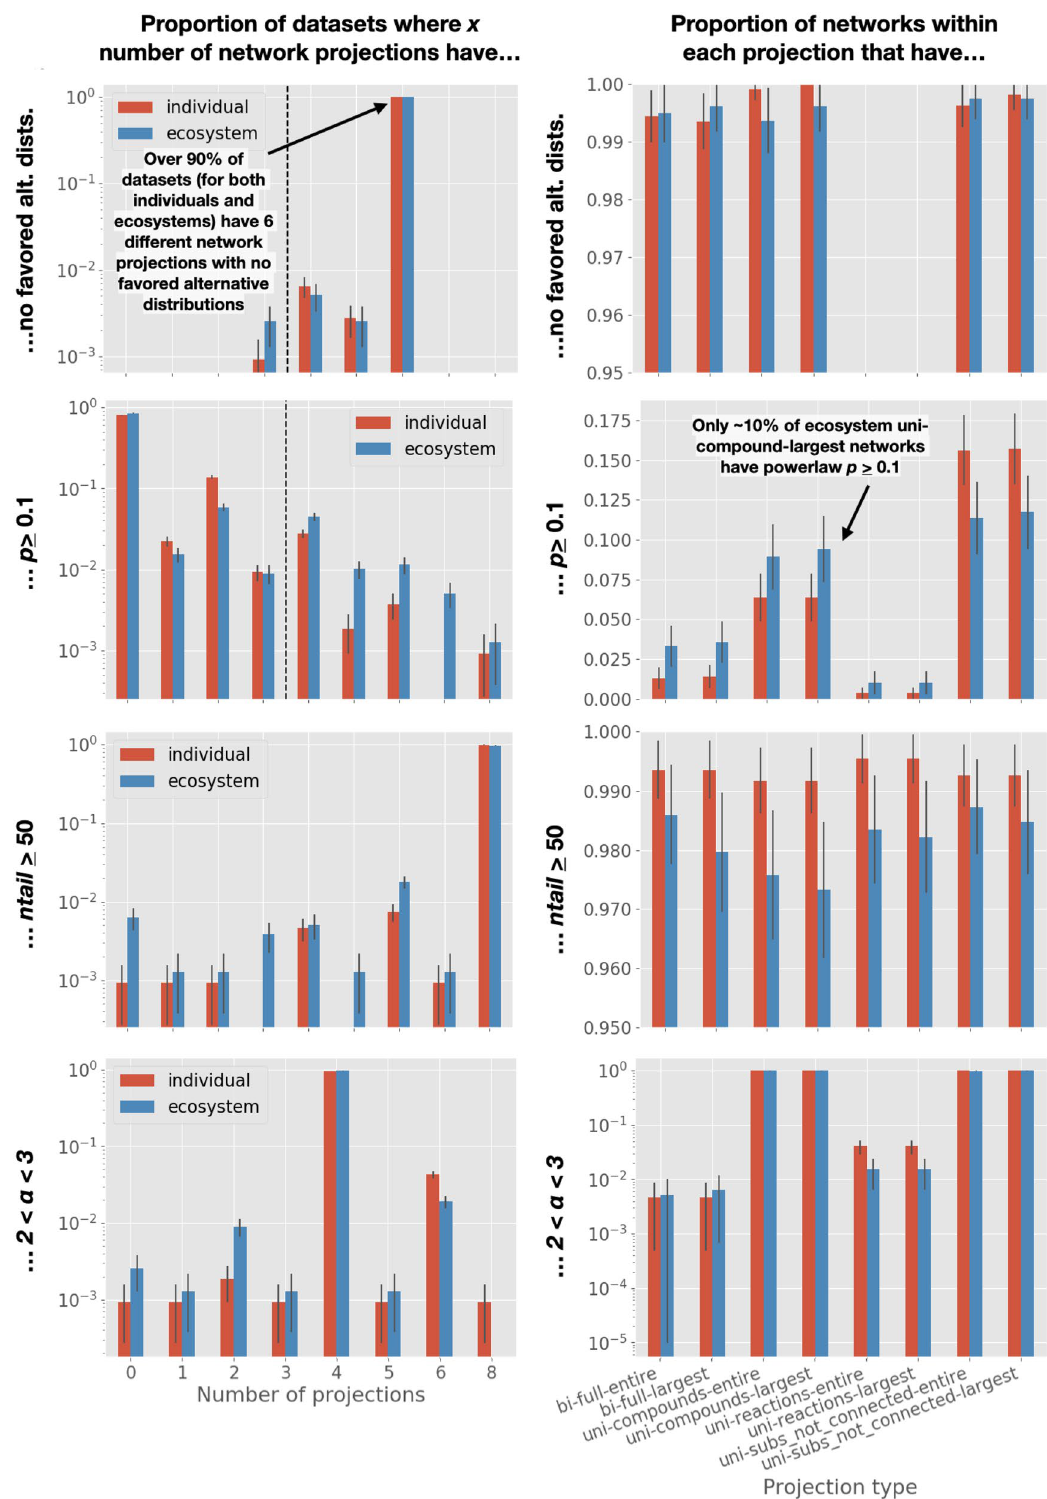
Figure 3. The number of network projections within each dataset which meet some scale-free criteria. Left column The number of network projections within each dataset which meet some scale free-criteria, where each dataset falls into one of nine bins. Normalized to total number of datasets in a level. Criteria from top to bottom: No alternative 0.1 (2nd row); n 50 (3rd row); distributions favored over power-law in log-likelihood ratio (1st row); p tail ≥ ≥ 2 < α < 3 (4th row). Dashed lines show: the cutoff for number of networks in a dataset required to meet the threshold criteria for “Super-Weak” (1st row), and “Weakest” (2nd row). Right column The number of network projections, across all datasets, which meet some scale-free criteria, binned by projection type. Normalized to the total number of each projection within a level. Criteria same as left column. Red bars indicate individual-level datasets/networks, and blue bars indicate ecosystem-level datasets/networks. Black error bars show